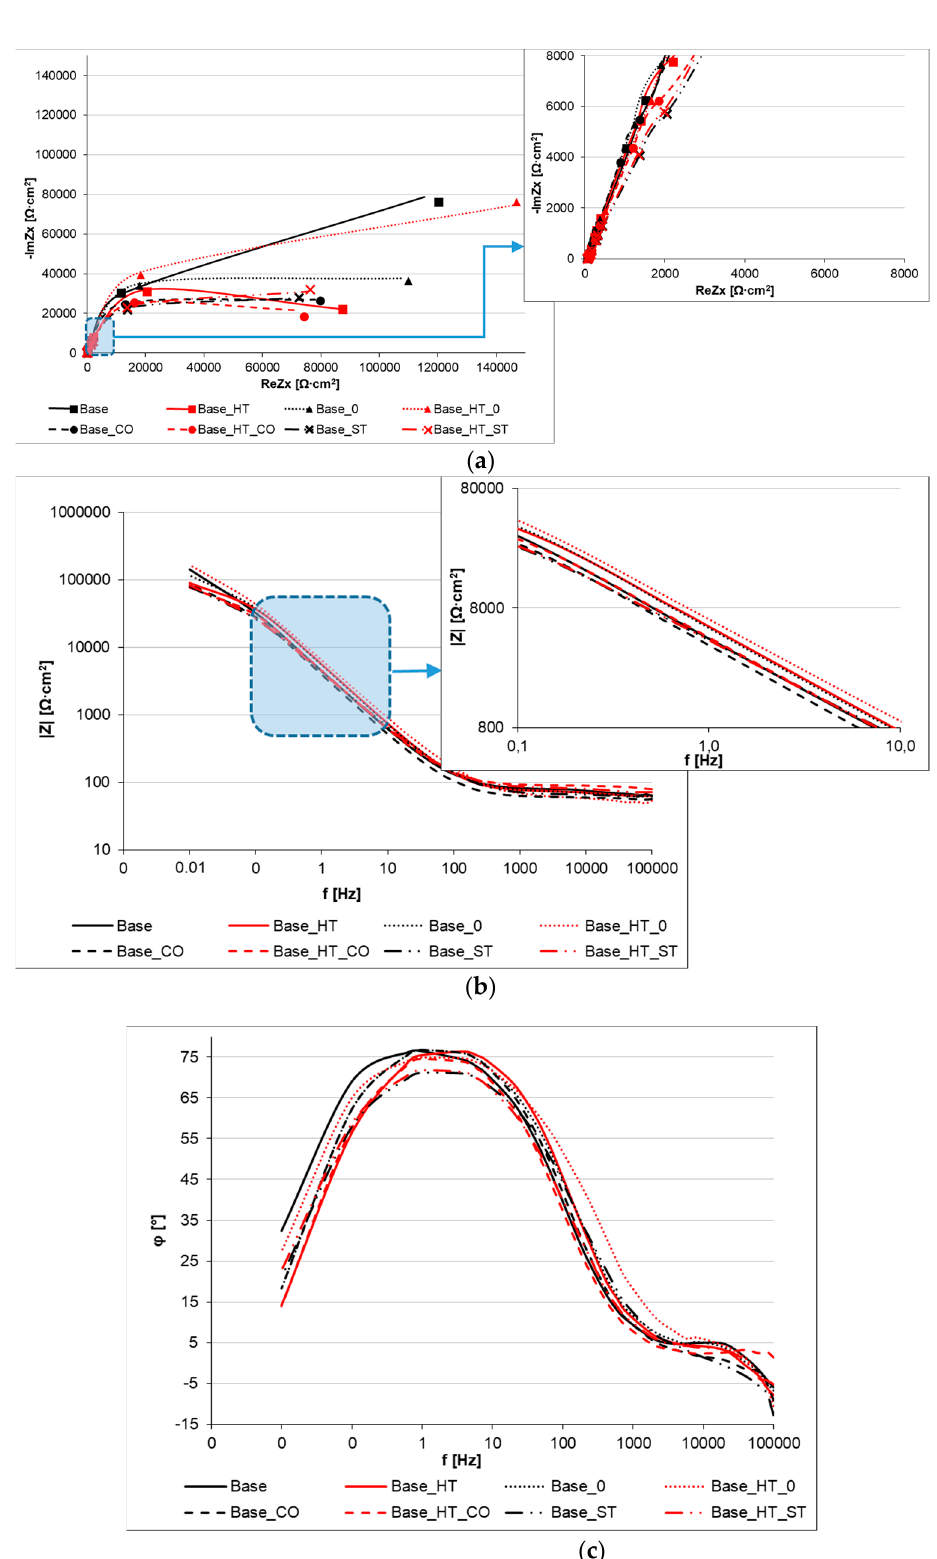
Figure 2. Impedance spectra of materials (for stationary potentials): ( a ) Nyquist representation; ( b ) Bode representation modulus vs. frequency, ( c ) Bode representation phase angle vs. frequency.